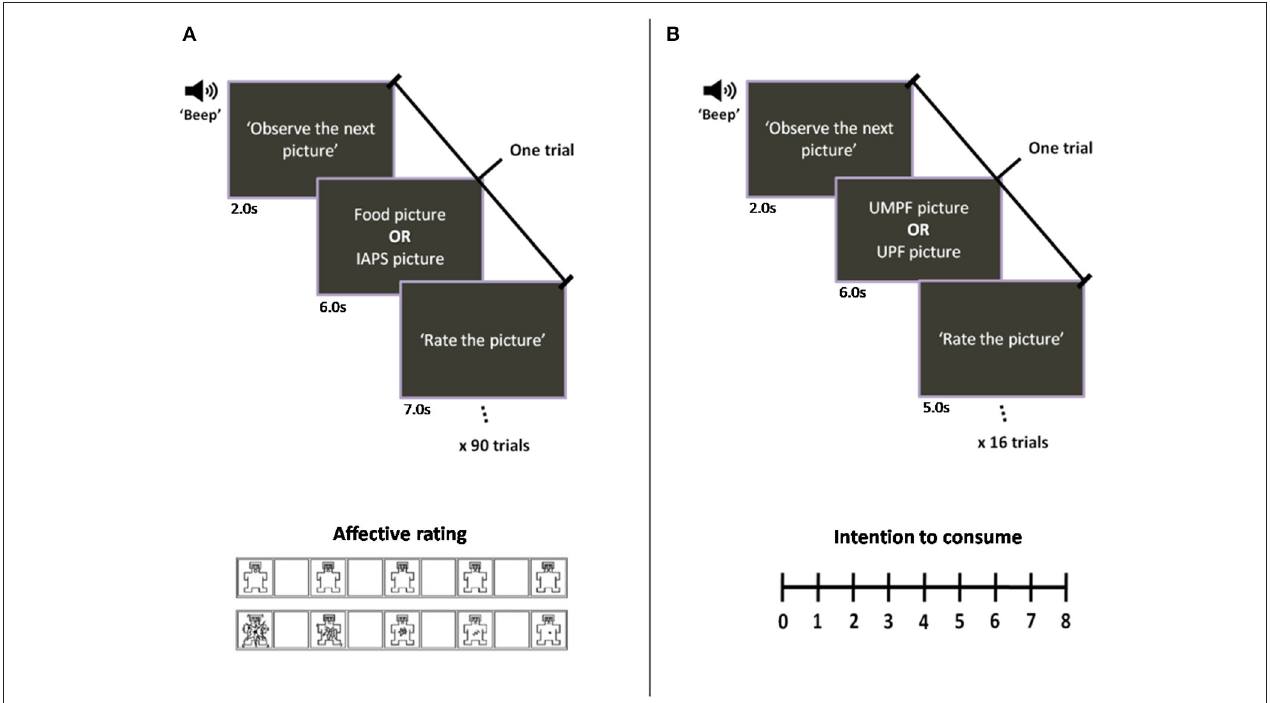
FIGURE 1 | Schematic representation of the sequence of events in a trial. The experimental session was divided into two tasks. (A) Affective rating task: 16 food pictures (8 UPF and 8 UMPF) interspersed with 74 pictures in different affective categories from the IAPS were displayed, and the participants rated how they felt while viewing each picture by marking the Self-Assessment Manikin scale. (B) After the affective rating task, participants performed a second task in which they rated their “intention to consume” each of the 16 foods presented in the pictures on a scale ranging from 0 (none) to 8 (maximum). UMPF, unprocessed/minimally processed foods; UPF, ultra-processed